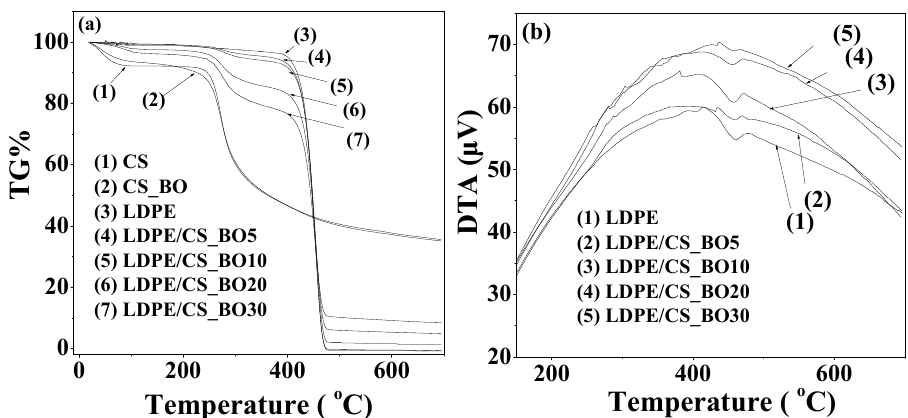
Figure 3. ( a ) Thermogravimetric (TG) plots of the pure CS and of the CS_BO blend as well as of all the obtained LDPE/CS_BO films, ( b ) differential thermal analysis (DTA) plots of all the obtained LDPE/CS_BO films.